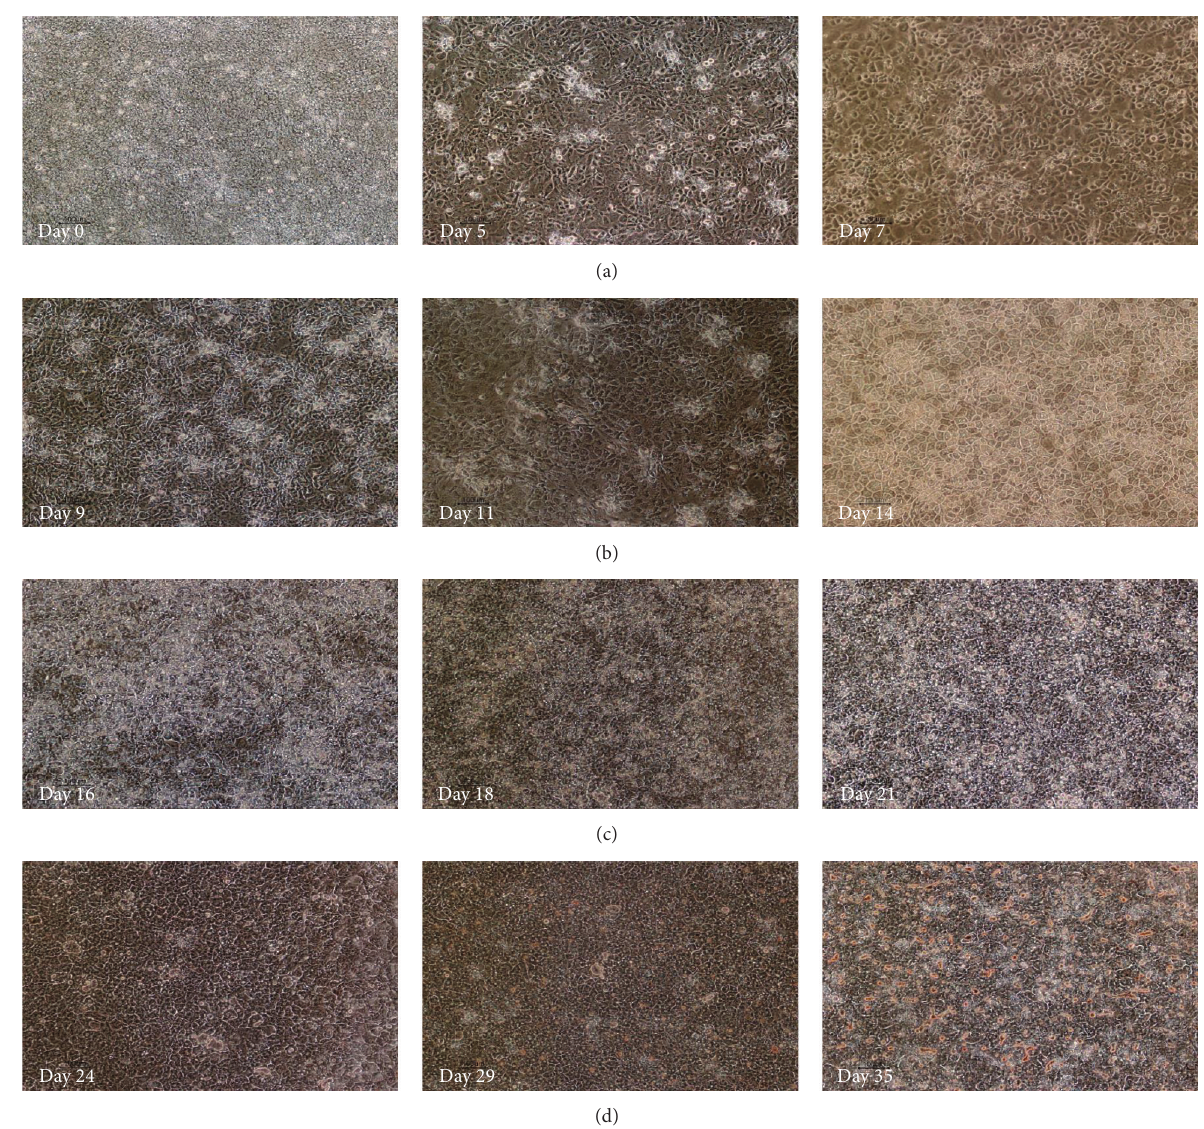
Figure 2: Morphology of cells during hepatic differentiation at days 0, 5, 7, 9 (ChiPSC6b), 11 (P11012), 14 (ChiPSC6b), 16 (P11012), 18 (P11012), 21 (P11012), 24 (SA121), 29 (AS034), and 35 (ChiPSC6b) magnification 10x. (a) Human PSCs cultured in Cellartis DEF-CS demonstrate stem cell morphology at day 0 (AS034). (b) At day 5 (P11025) and day 7 (SA181) the cells show a characteristic DE morphology. (c) Following the application of HEP progenitor medium, the DE cells transferred gradually to hepatoblasts. (d) The cells acquired the hepatocyte morphology (polygonal cells) following the application of HEP maturation medium (3Ap) and supplement (3Bp). In the HEP maintenance medium (4) the cells preserve typical hepatocyte morphology, polygonal cells with single- or